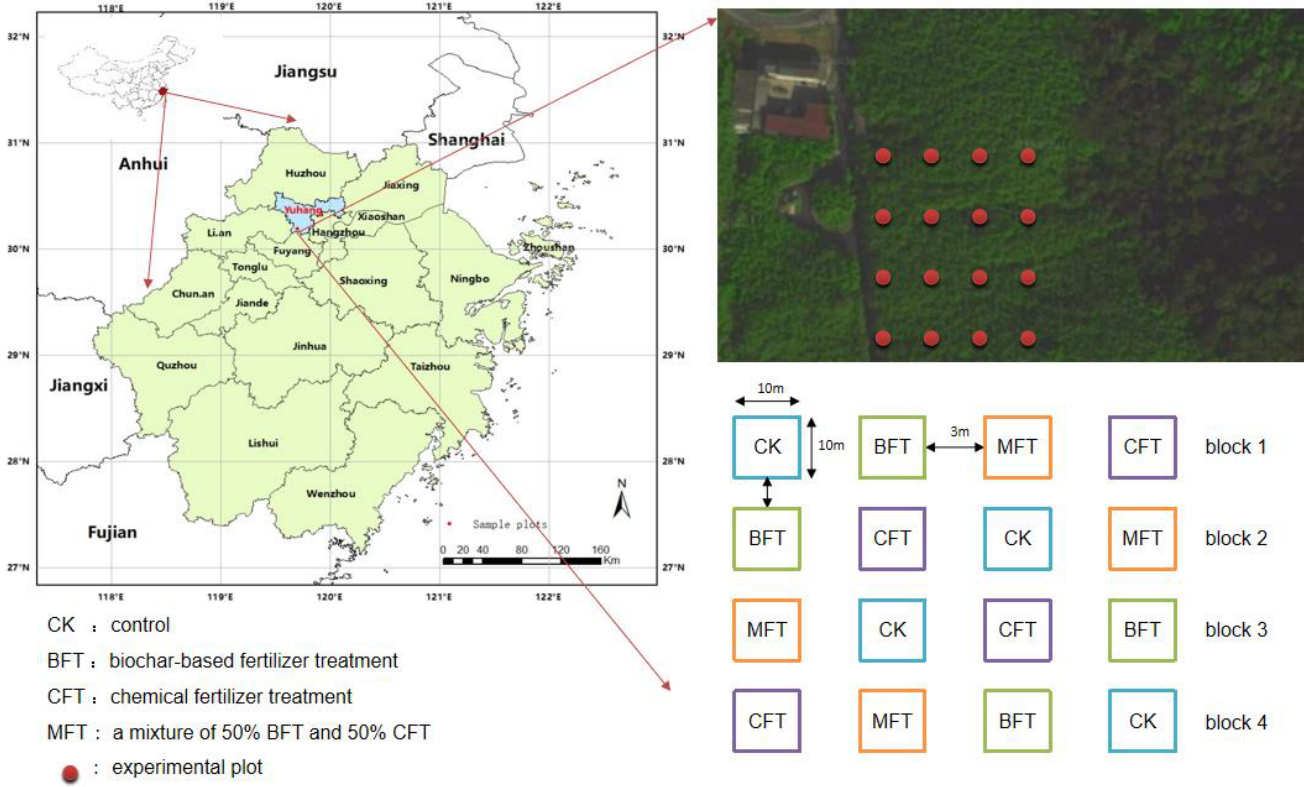
Figure 1. Location of the study area and the scheme of the experimental approach.